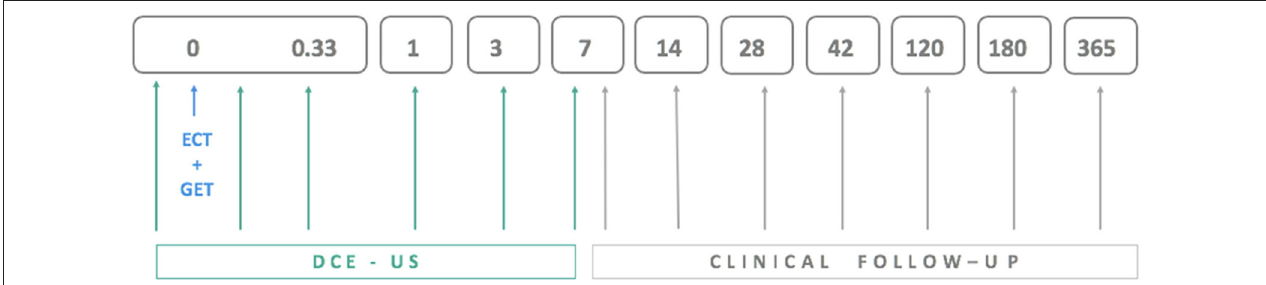
FIGURE 1 | Schedule for electrochemotherapy combined with gene electrotransfer of plasmid DNA encoding interleukin IL-12 (ECT + GET), dynamic contrast-enhanced ultrasound (DCE-US) examinations and clinical follow-up examinations, which included tumor volume measurement.